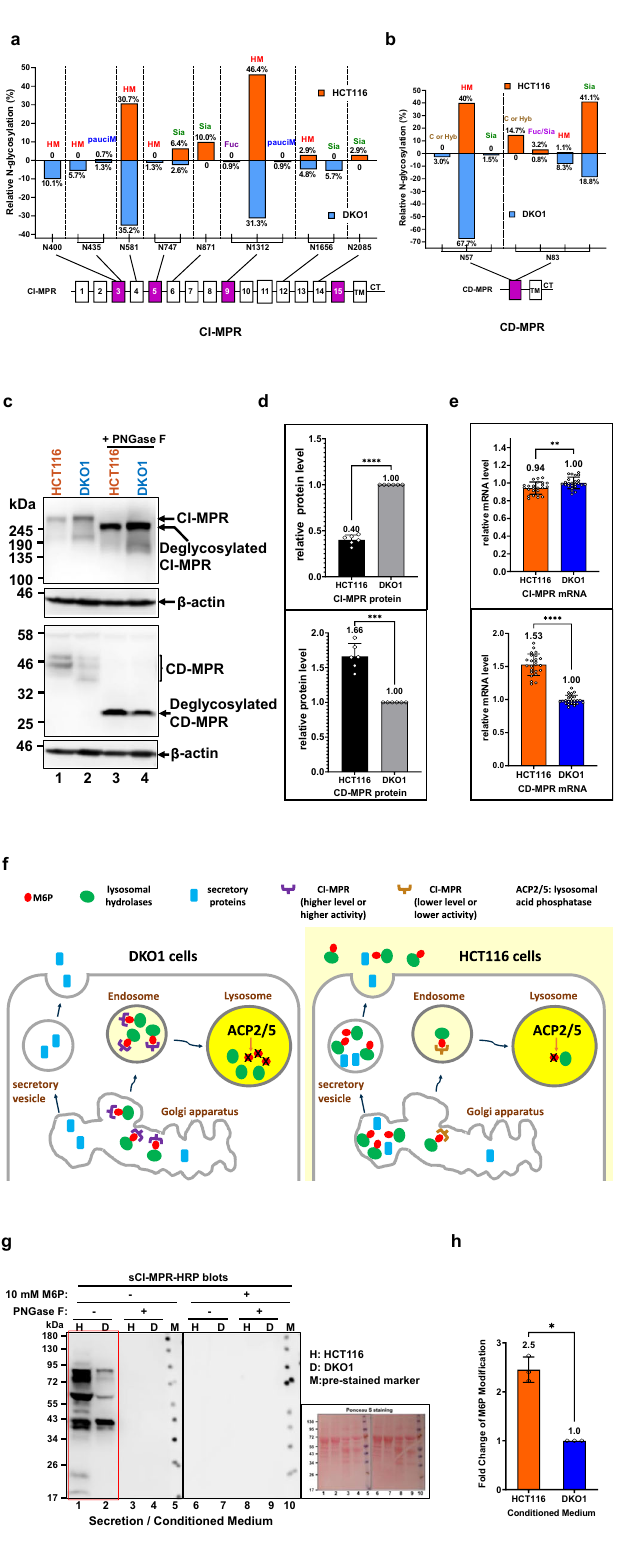
cancer cells can be the result of increased level/activity of sialyl- transferases, reduced level/activity of sialidases, or a combination of both 42 . In our N-glycoproteomes, no sialyltransferases were observed. However, the N-glycosylation of Sialidase-1 (Q99519| NEUR1) was detected with 37 and 7 total N-glyco PSM in DKO1 and HCT116 cells, respectively. This suggests that Sialidase-1